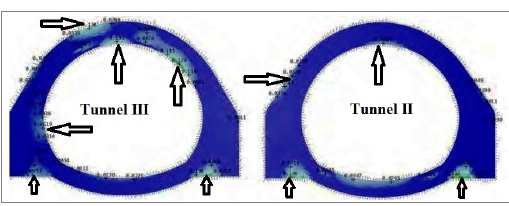
Figure 10. Tensile damage to Tunnels II and III by fissures in phase 500 ([2] – modified).